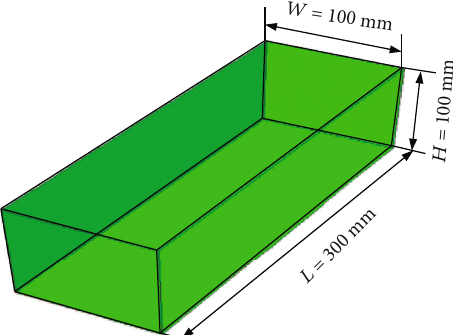
Figure 2: A hollow cuboid.